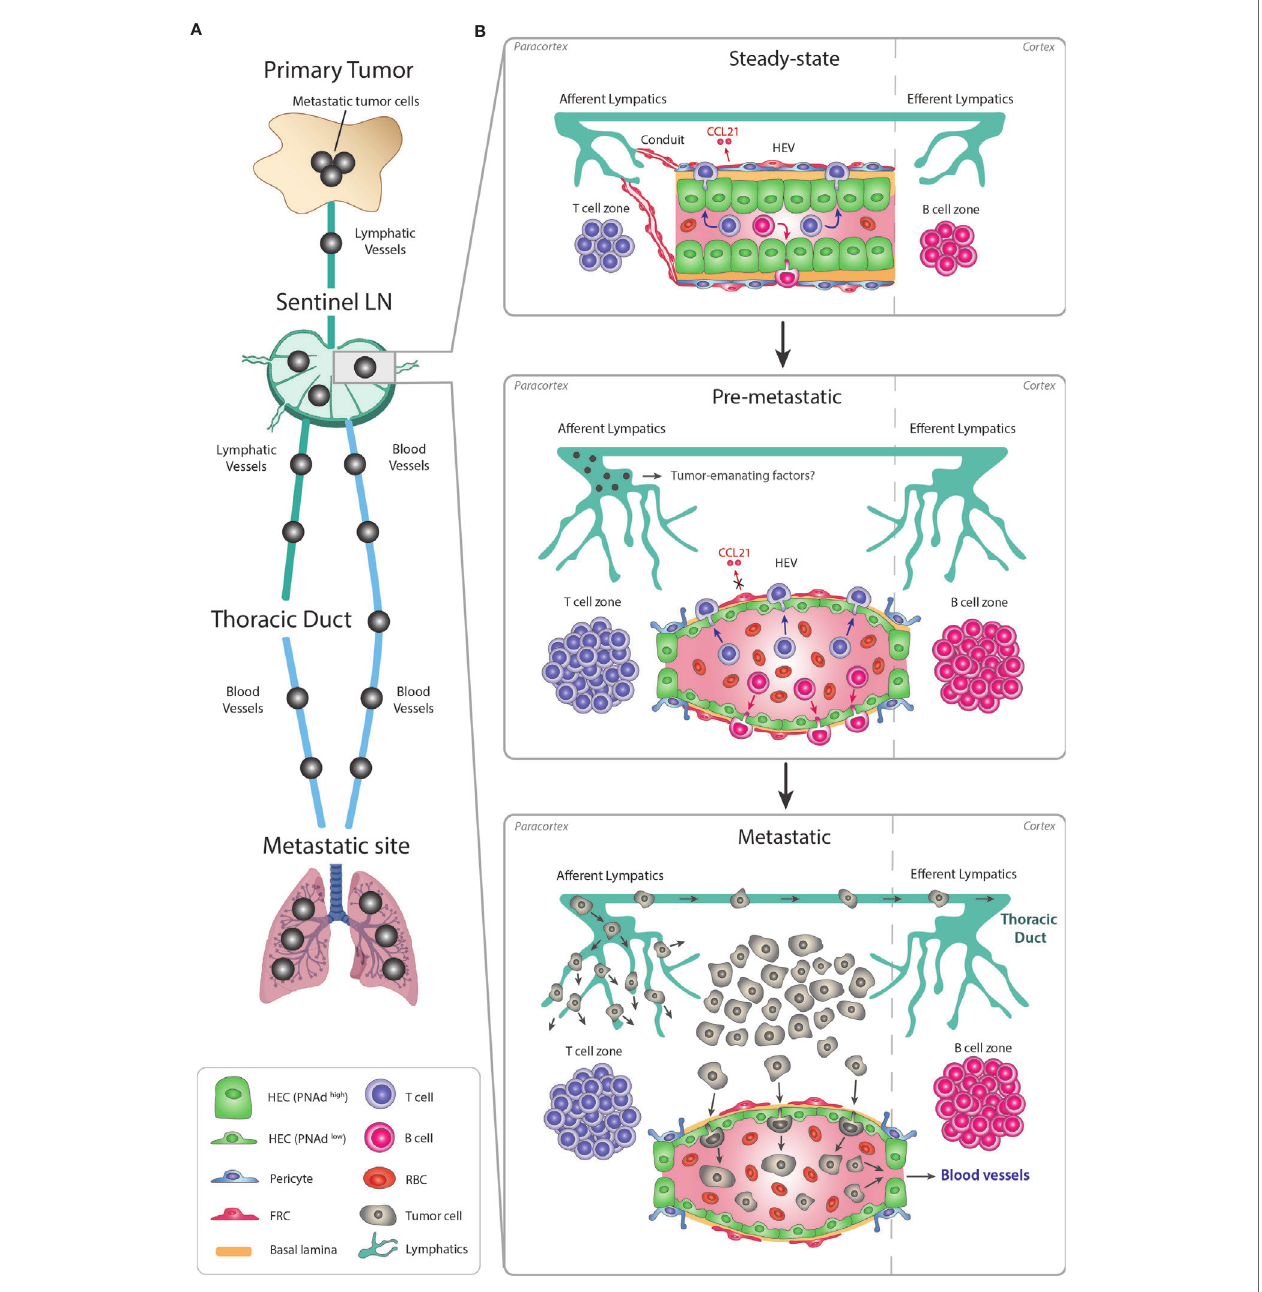
FIGURE 3 | Remodeling of LN-HEVs during cancer metastasis. (A) Metastasis is a stepwise process leading to the dissemination of cancer cells from the primary tumor towards preferential metastatic sites. Most commonly, metastatic cancer cells use the lymphatic system to exit the primary tumor, reach a proximal sentinel LN, circulate into adjacent LNs and eventually drain from the thoracic duct into the systemic venous system, thus spreading towards metastatic sites (e.g., lungs). Metastatic tumor cells in the LN parenchyma can also directly intravasate into the bloodstream via LN-HEVs and disseminate towards metastatic sites. (B) This alternative route involves an important remodeling of the sentinel LN already at the pre-metastatic stage, in preparation for the arrival of cancer cells. Overall, the sentinel LN expands, as evidenced by 1- expanded T and B cell compartments in the paracortex and cortex, respectively, and by 2- an extensive lymphangiogenesis. Importantly, HEVs are remodeled as 1- HECs switch to a PNAd low fl at phenotype with thin-walled basal lamina and enlarged lumens fi lled with numerous RBCs, and 2- CCL21 expression is dysregulated in FRCs, suggesting impaired lymphocyte-recruiting functions of sentinel LN-HEVs. Whether tumor cells from the primary site secrete speci fi c factors preparing this pre-metastatic niche prior to their circulation into the sentinel LN remains to be elucidated. Altogether, the expanded sentinel LN and remodeled HEVs allow the direct spreading of cancer cells from afferent lymphatics into the venous bloodstream during the metastatic stage. LN, lymph node; HEV, high endothelial venule; HEC, high endothelial cell; RBC, red blood cell; FRC, fi broblastic reticular